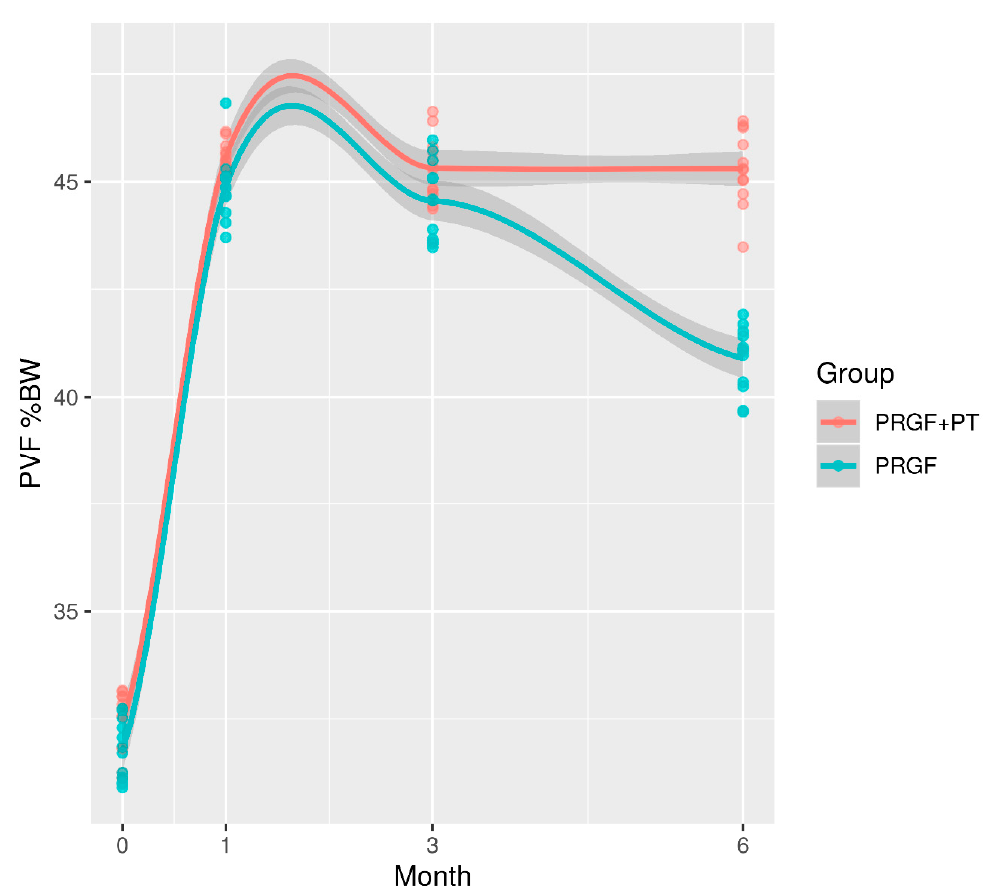
Figure 1. Evolution of PVF (normalized to body weight) in both groups during the 180 days of the study. PVF: Peak vertical force; PRGF: Plasma rich in growth factors; PT: Physical therapy.